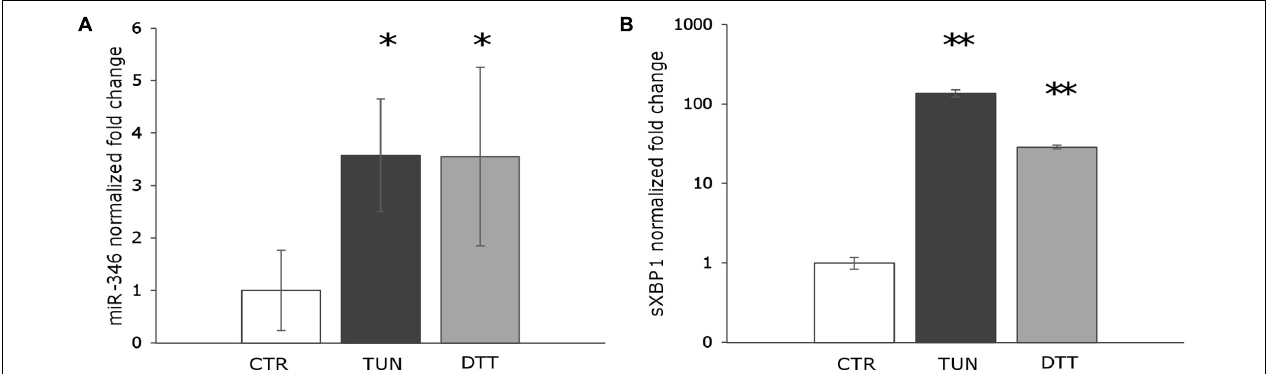
FIGURE 1 | miR-346 is upregulated following ER stress in human monocytic cell line. (A) miR-346 expression in THP-1 cells treated with 0.5 µ g/ml tunicamycin for 4 h (dark gray) or 1 mM dithiothreitol for 1 h (light gray) ( n = 4). (B) sXBP1 expression in the same cells used to monitor miR-346 expression ( n = 4). CTR, untreated cells; TUN, cells treated with tunicamycin; DTT, cells treated with dithiothreitol. ∗ p < 0.05; ∗∗ p <